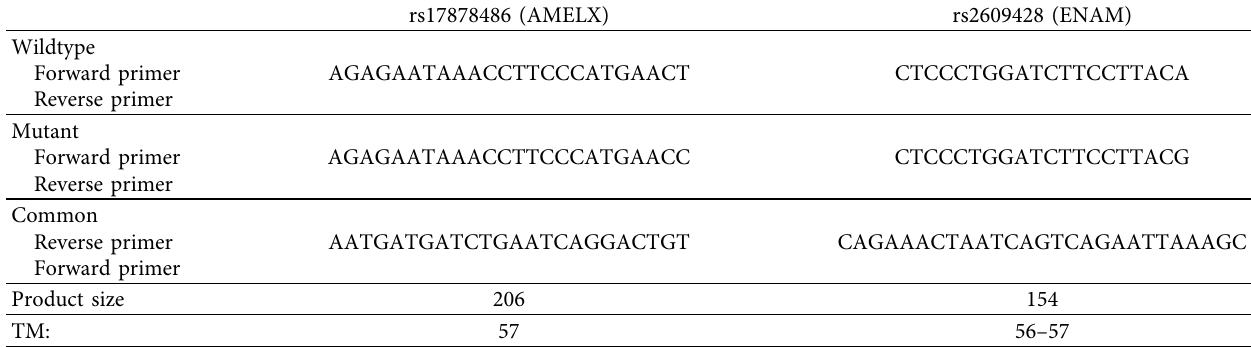
Table 1: Primer design for two SNPs of AMELX and ENAM